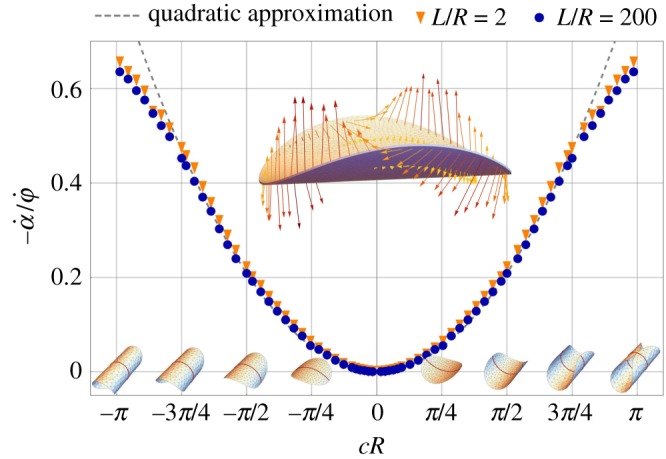
Rotational swimming velocity α˙ for a circular shell generated by the precession velocity of the curvature axis φ˙; blue dots, numerical results for a cylindrical box of radius L/R = 200; orange triangles, numerical results for a box of radius L/R = 2; dashed line, quadratic approximation for moderate curvature (4.3). Inset: fluid-to-structure net contact forces distribution for cR = 0.8 as found by extracting from the numerical simulation the jump of the contact force between the upper (+) and lower (–) shell surfaces, ***σn*** = σ+n+ − σ−n−.